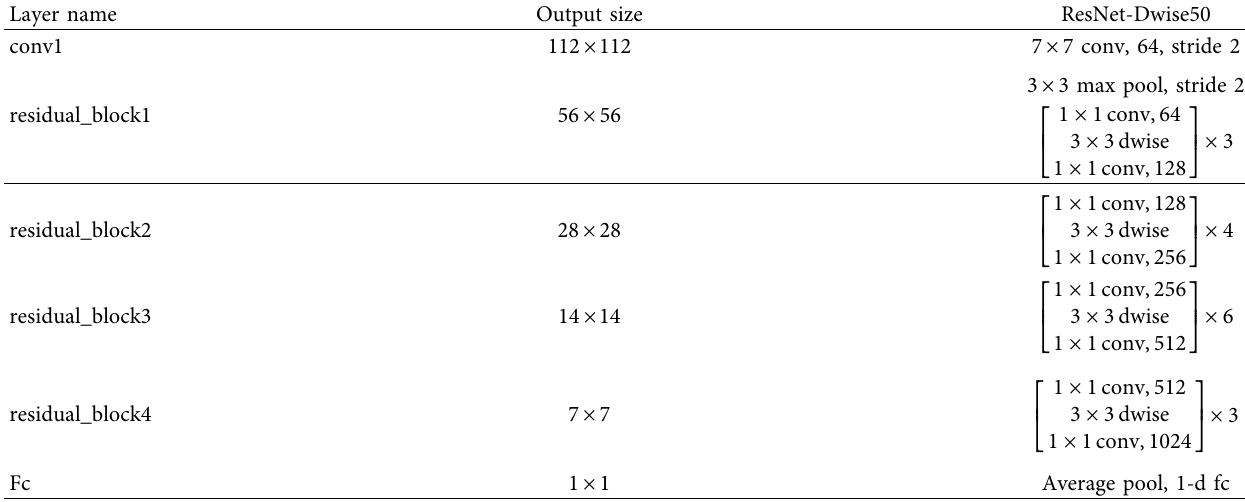
Table 1: Architecture of the ResNet-Dwise50 model.